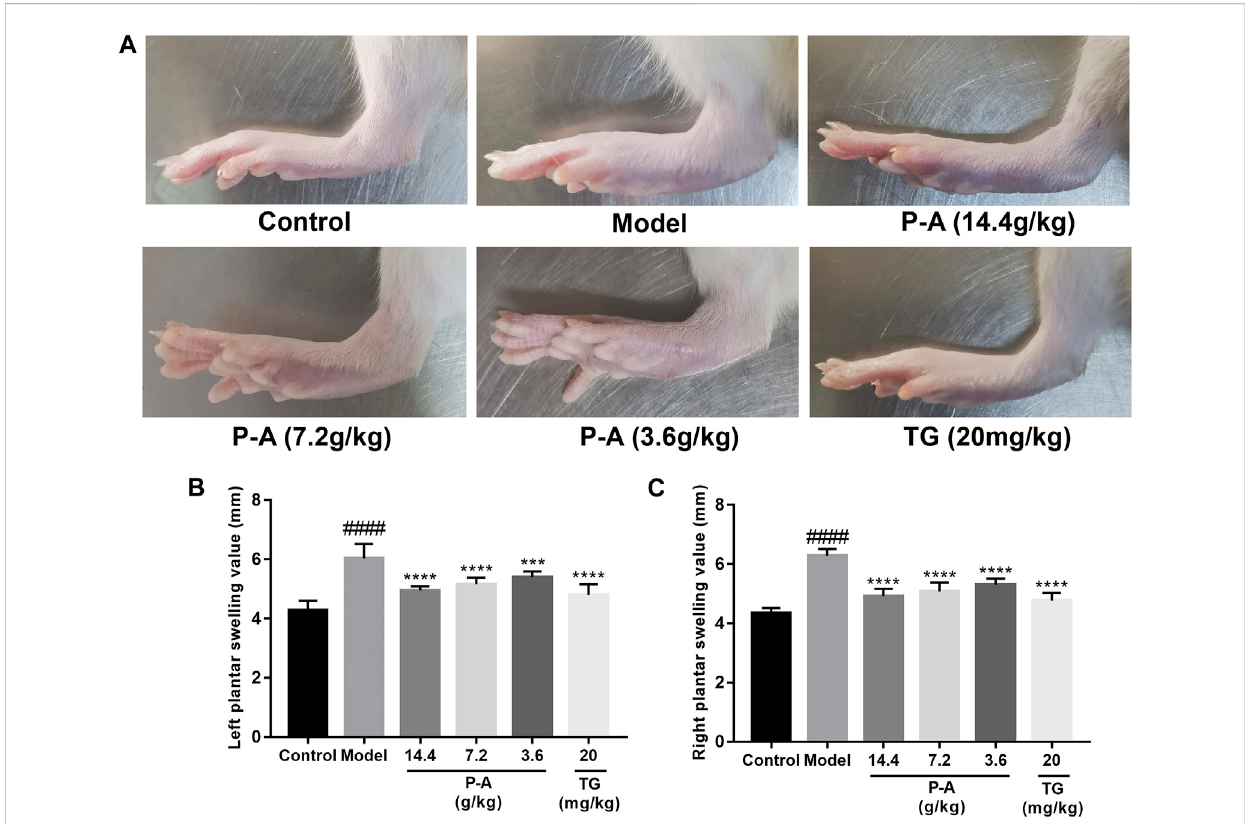
FIGURE 6 (A) Pathological phenotypic changes. (B) Left plantar swelling value. (C) Right plantar swelling